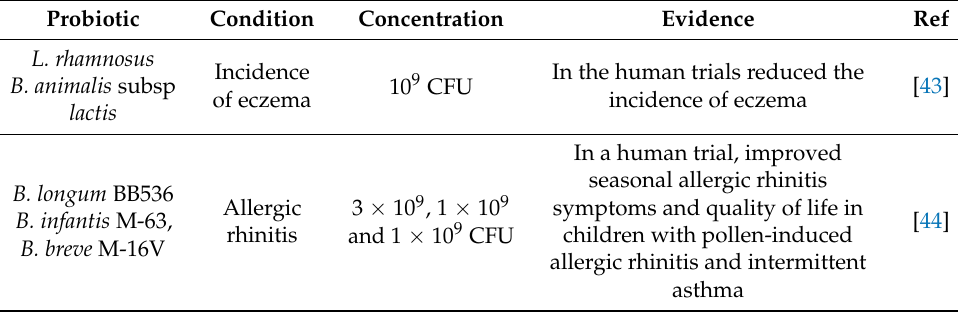
Table 2. Probiotics associated with attenuation of allergic